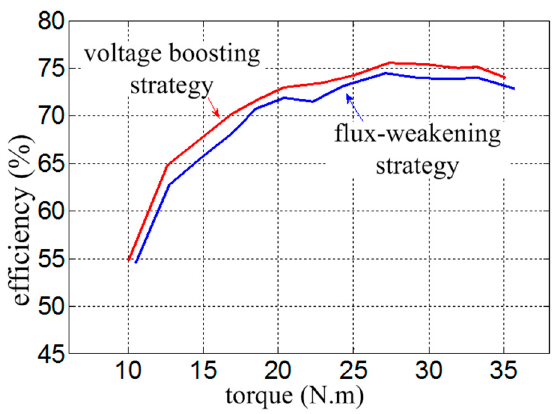
Figure 9. E ffi ciency comparison with di ff erent strategies at 650 r / Figure 9. Efficiency comparison with different strategies at 650 r/min. Figure 9. Efficiency comparison with different strategies at 650 r/min.